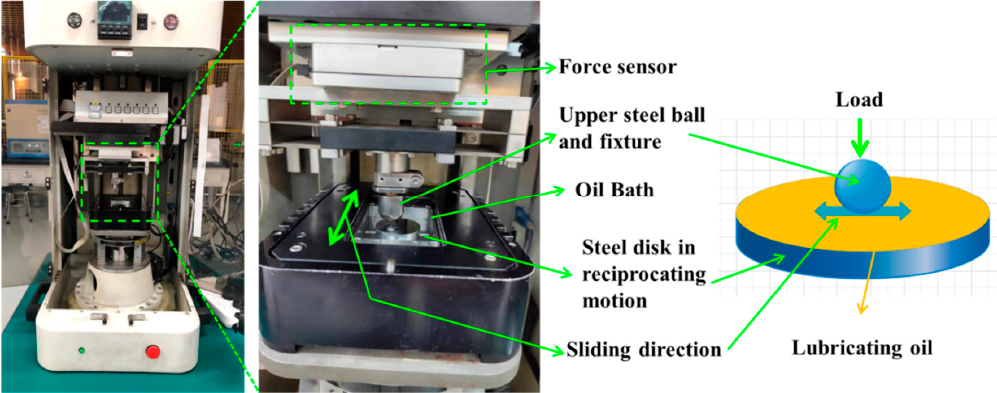
Figure 1. Schematic diagram of ball-on-disc tribometer.